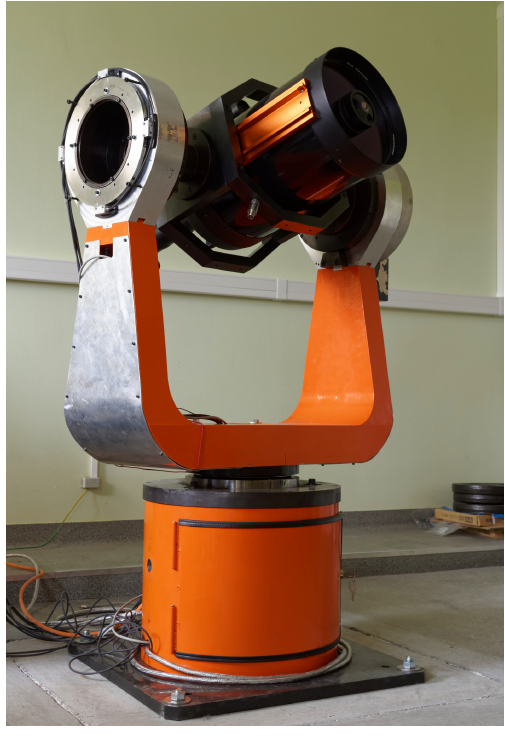
Figure 4. Laboratory setup equipped with the two-axis telescope